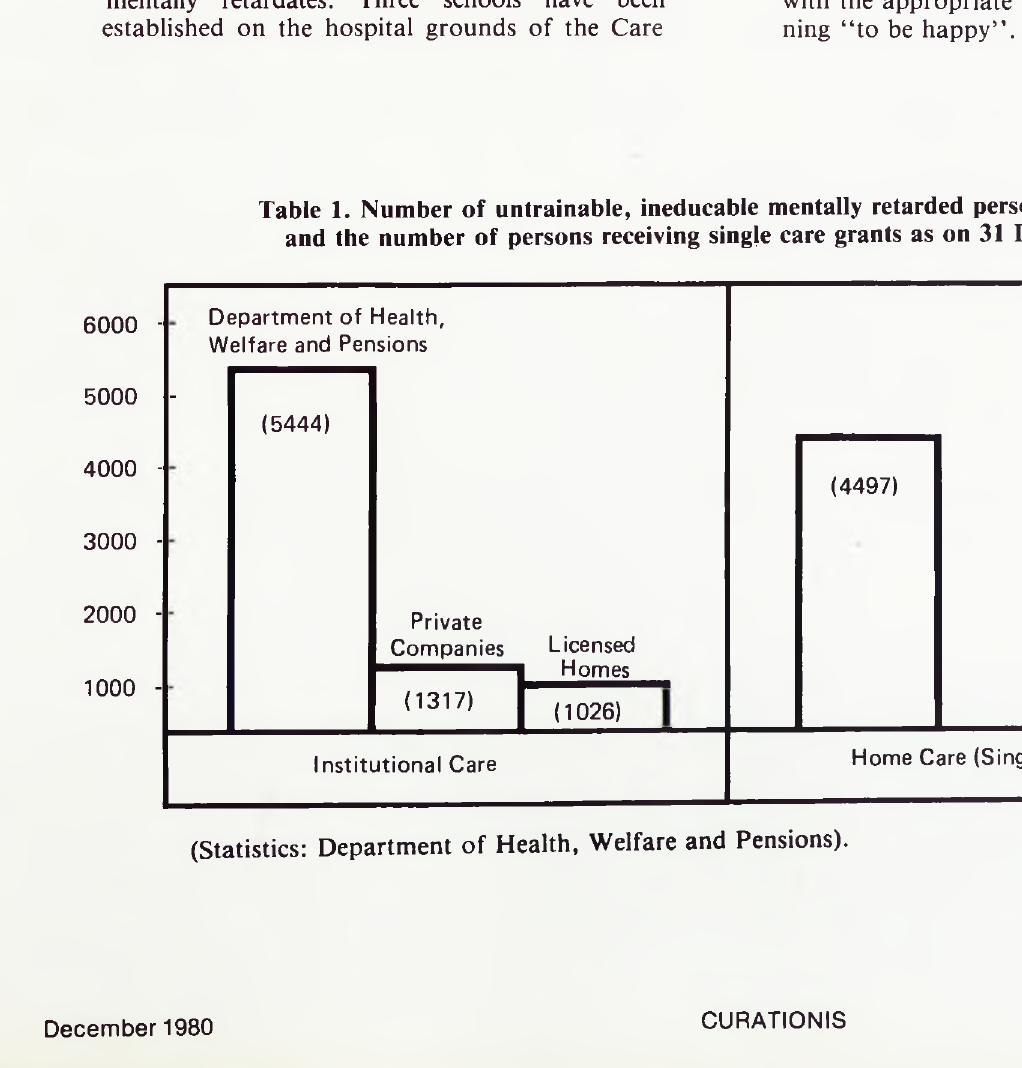
Table 1. Number of untrainable, ineducable mentally retarded persons in